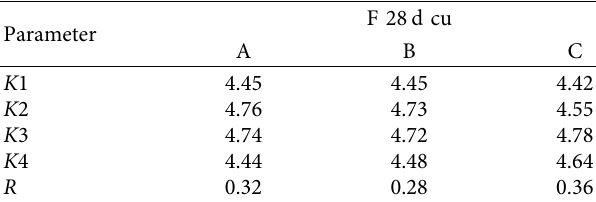
Table 3: Range analysis for the orthogonal